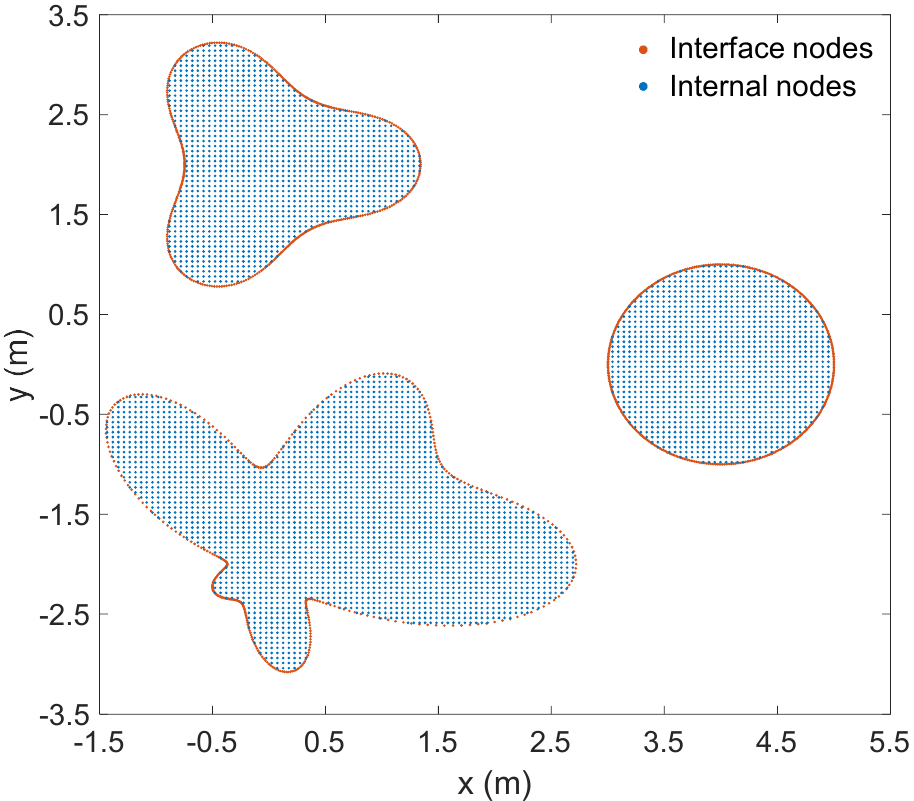
Figure 12. Node distribution of the coupling method.